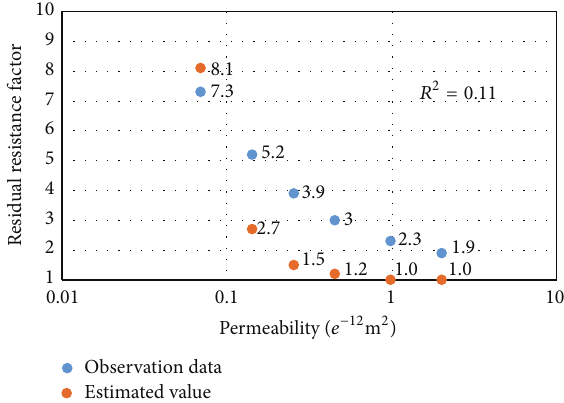
Figure 2: Matching results between observation and estimation using theoretical correlation function of RRF = 𝑎/𝑘 2 +